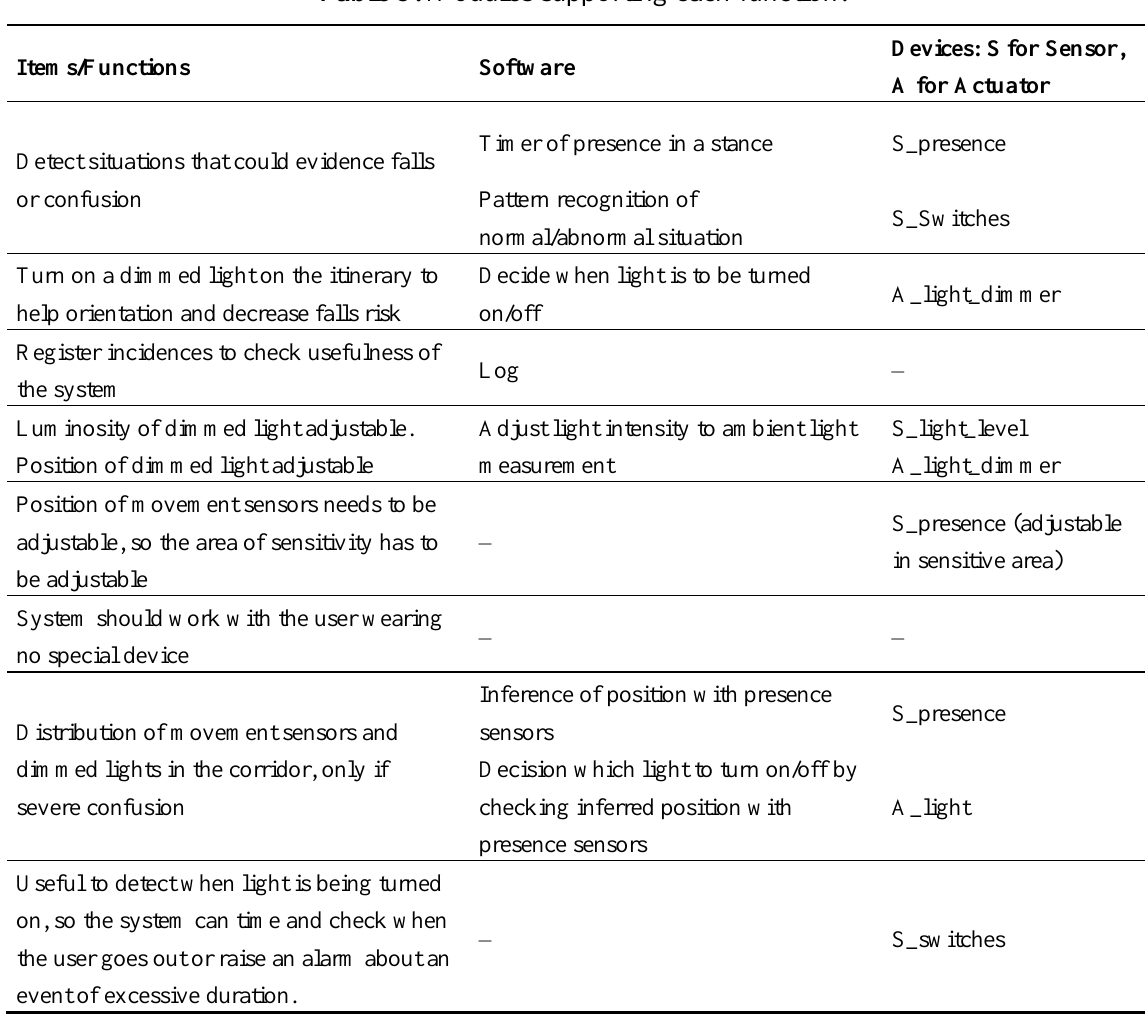
Table 9. Modules supporting each function.